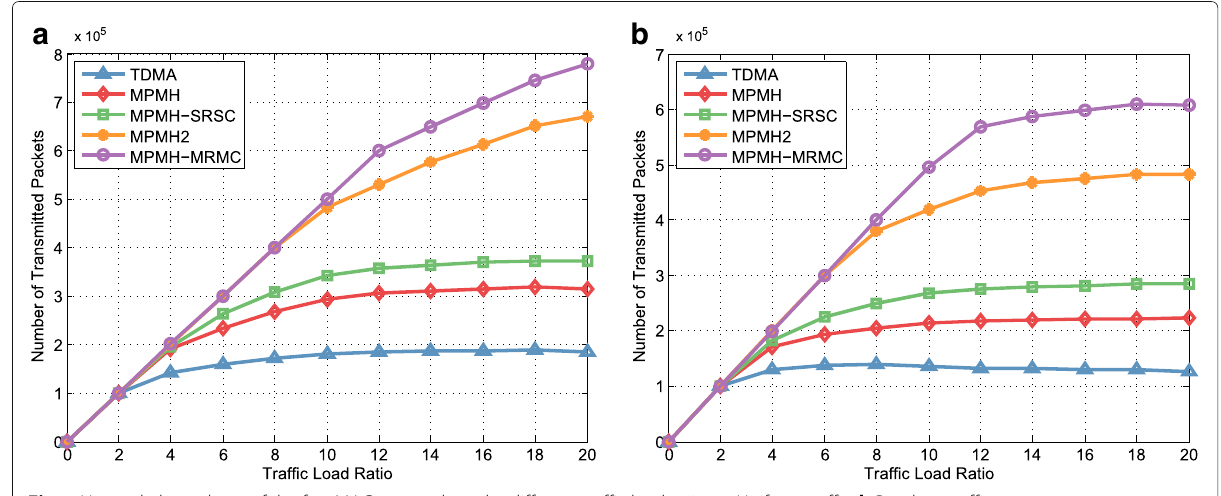
Fig. 5 Network throughput of the five MAC protocols under different traffic load ratios. a Uniform traffic. b Random traffic